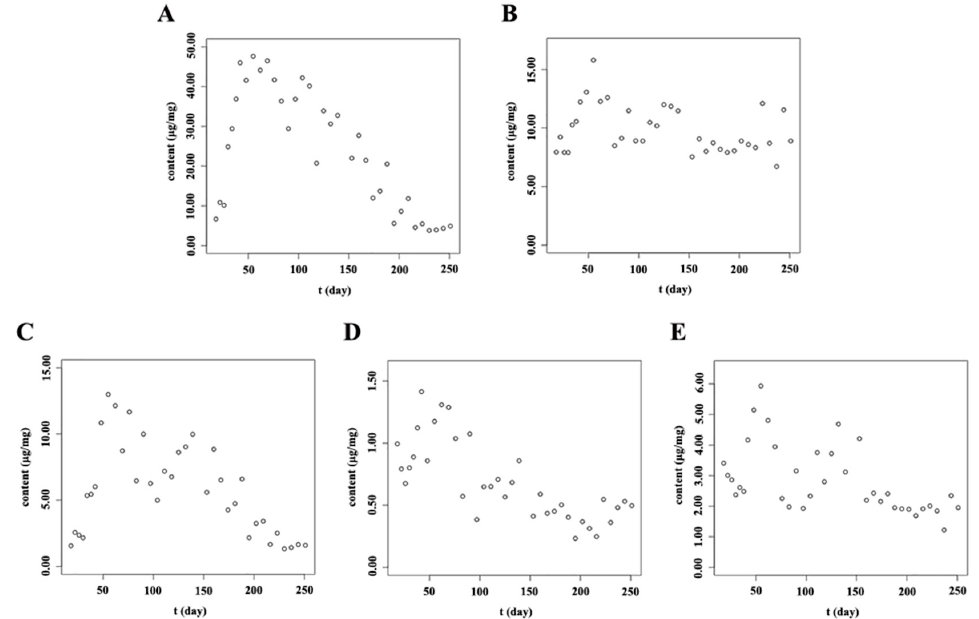
Figure 8. Accumulation patterns of main flavonoids in the stem of S. baicalensis . ( A ): Isocarthamidin-7- O - β - D -glucuronide; ( B ): Scutellarin; ( C ): Carthamidin-7- O - β - D -glucuronide; ( D ): Apigenin-7- O - β - D -glucuronide; ( E ): Baicalin; The units “ μ g/mg” meant the contents of analytes in per mg of freeze-dried samples.